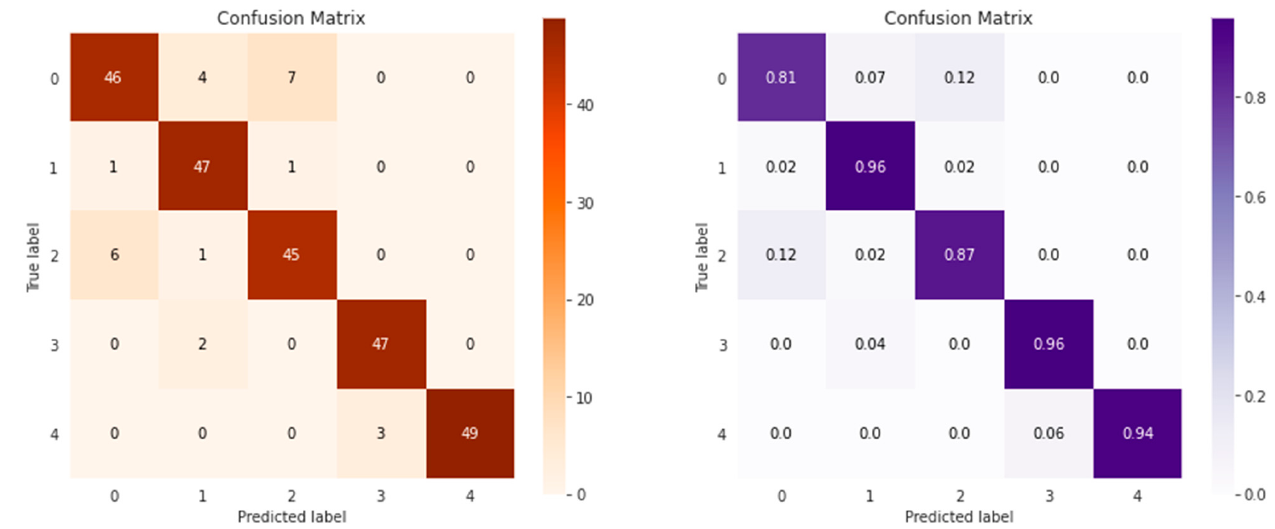
Figure 13. Confusion matrix on 3*3 configuration gives inside of classification model. The region of convergence is the same as the accuracy of a machine learning model. The micro average of the ROC curve is 0.98, which shows that the model performance is very reliable shown in Figure 14.